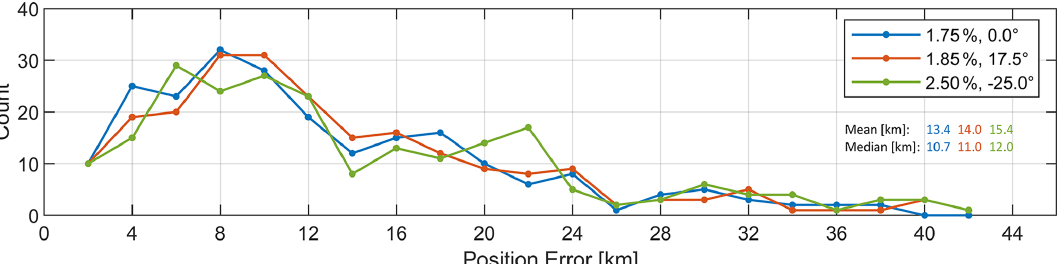
Figure 3. Distribution of errors for predicted positions using initial positions from Worsley’s navigational fixes and simulated ERA-20C surface wind-driven drift. The computation is for the period 18 January–21 November 1915; the time during which Endurance was beset and drifting with the sea ice. The three sensitivity test cases discussed in Sect. 3.4 are presented (for each case, the legend refers to the wind factor and the turning angle). Also presented are mean and median errors.